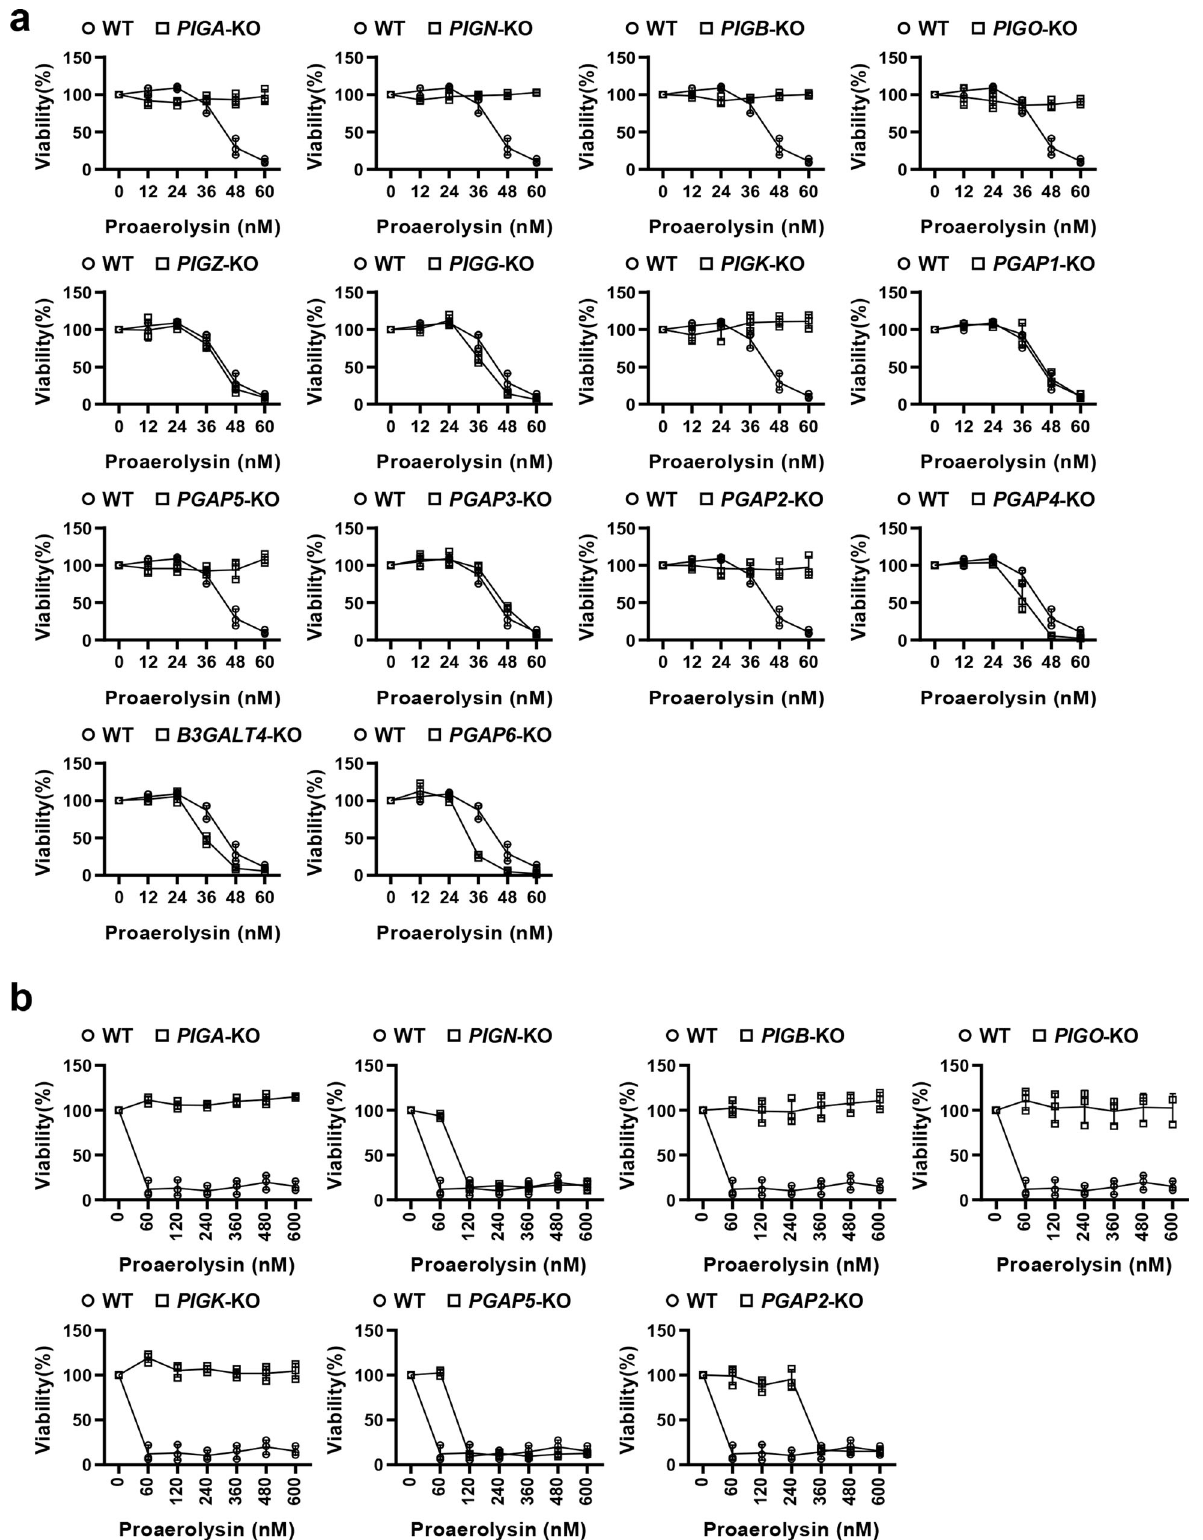
Fig. 5 Aerolysin recognizes glycan-remodeled GPI structures by PGAP5. a Fourteen GPI-KO cell lines were treated with different concentrations of proaerolysin (0, 12, 24, 36, 48, and 60 nM), and cell viability was analyzed by Cell Counting Kit-8 (CCK-8, MedChemExpress). HEK293 WT cells were used as a control. The cell viability of cells treated without proaerolysin was set as 1, and the relative viability was plotted as the mean ± SD from three parallel experiments. b Cell lines that showed resistance to aerolysin at low concentrations (60 nM) were selected and treated with high concentrations of proaerolysin (up to 600 nM). The cell viability was plotted as described